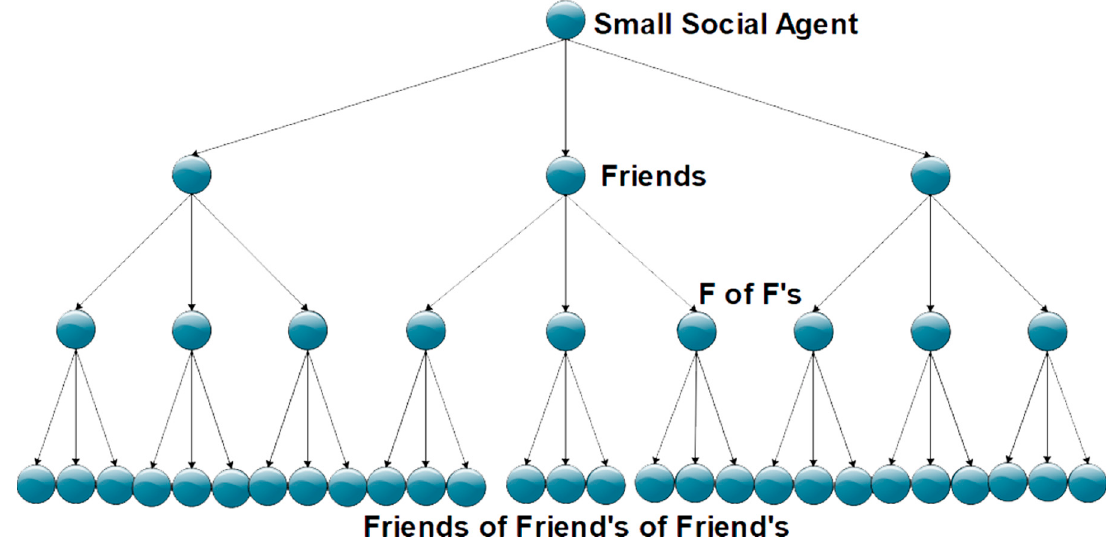
Figure 3. The balanced tree representation of the small world network.